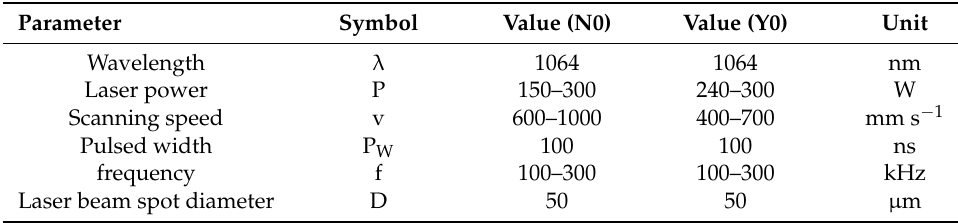
Table 2. Experimental parameters of laser removal